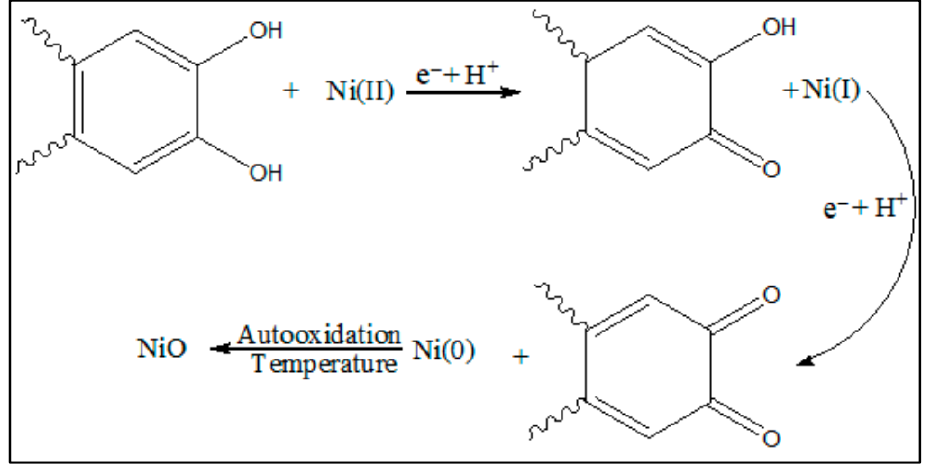
Figure 1. Suggested mechanism for the synthesis of NiO by green